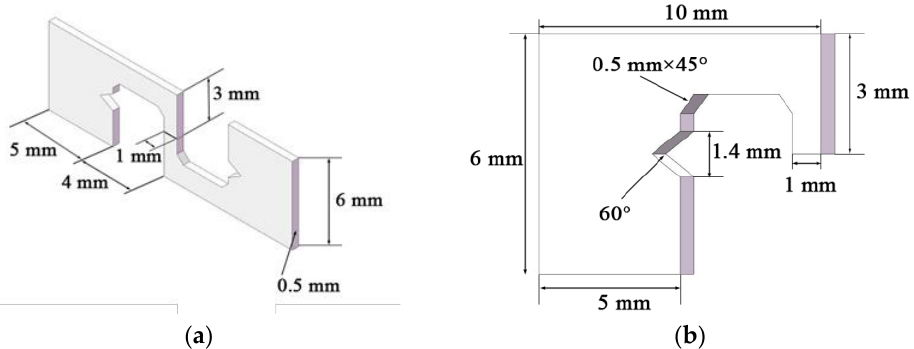
Figure 1. Shape and size of the solder specimen: ( a ) specimen shape; ( b ) specimen